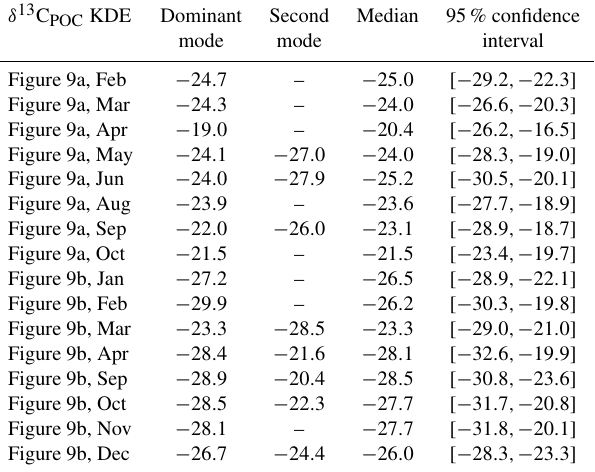
Table A4. Statistical properties of the KDEs derived for Fig. 9 eval- uated on an equidistant grid over [− 35 , − 15 ] with 1001 grid points: the first column indicates the respective KDE, the following two its modes, the fourth the median and the fifth the 95% confidence interval of the respective KDE. All values are given in per mill.